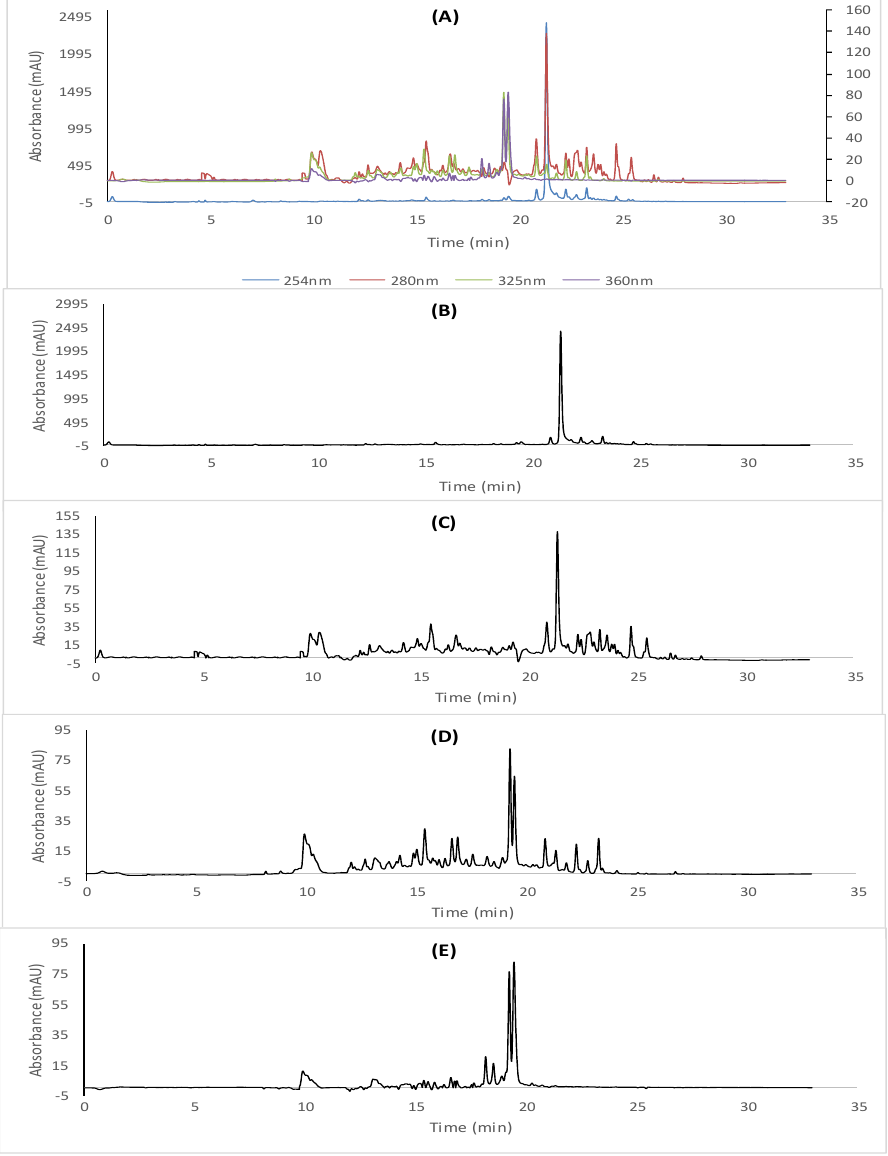
Figure 1. LC − DAD chromatogram of secondary metabolites from R. tuberculata aqueous extract. ( A ) Global chromatograms detected at four wavelengths: ( B ) at 254 nm, ( C ) at 280 nm ( D ), at 325 nm and ( E ) at 360 nm. Table 1. Quantification of phenolic compounds in R. tuberculata extracts using cLC ‐ DAD system.